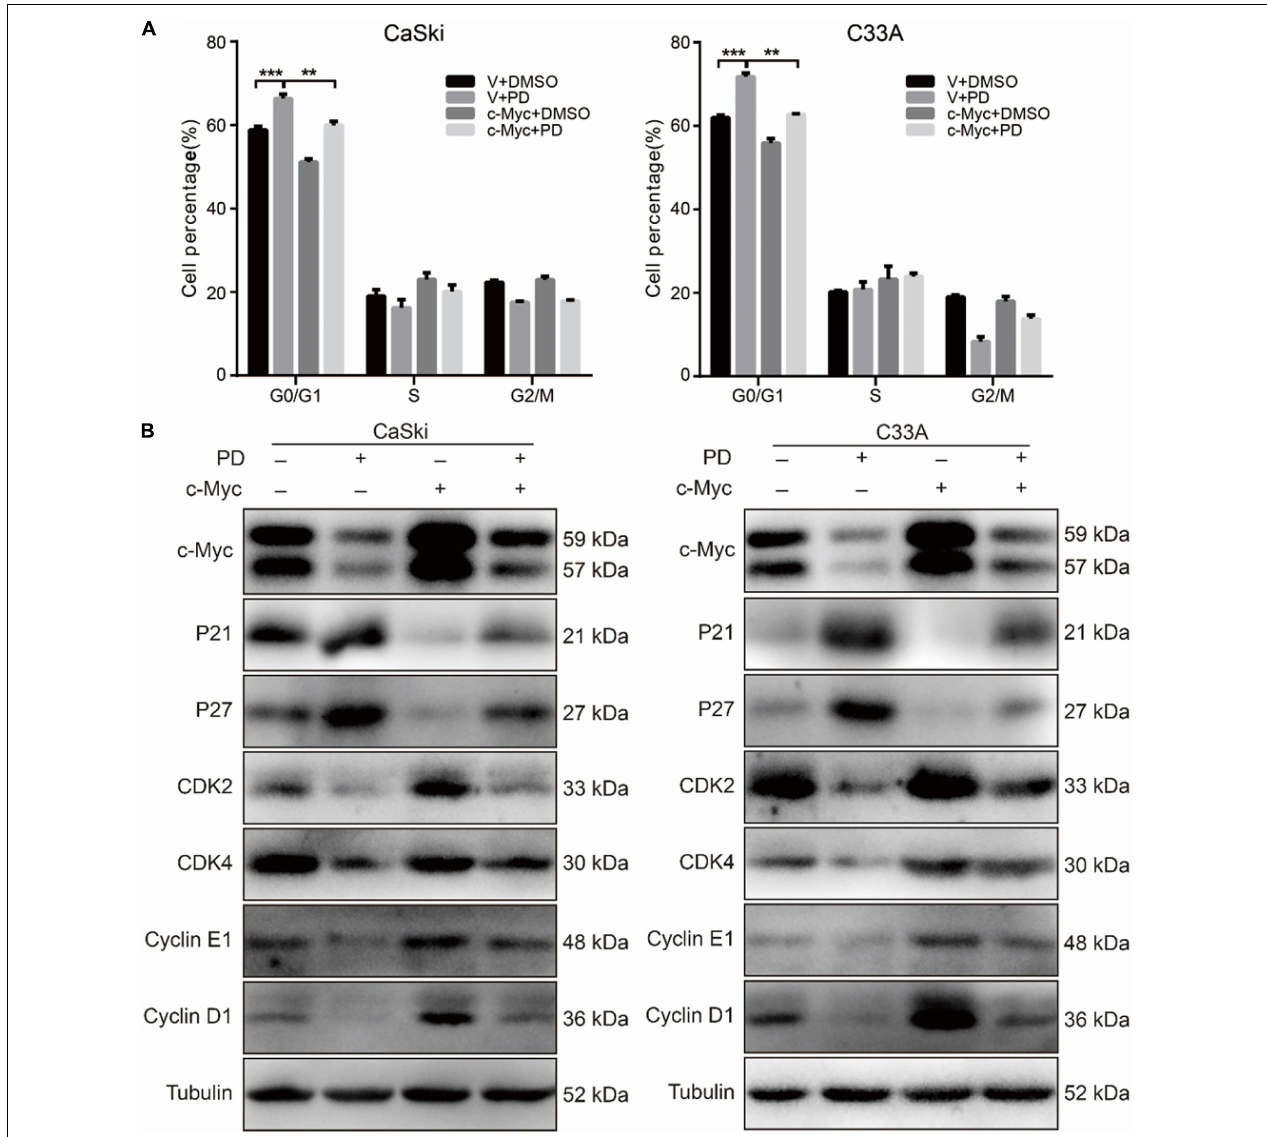
FIGURE 5 | The upregulation of c-Myc rescues polydatin-induced cell cycle arrest. (A) The cell cycle of CaSki and C33A cells was analyzed by flow cytometry in c-Myc-overexpressed cells as well as vector cells after being treated with dimethyl sulfoxide (DMSO) or 200 µ M of polydatin for 48 h. (B) Western blot analysis of cell cycle-related proteins in c-Myc-overexpressed CaSki and C33A cells as well as vector cells after being treated with DMSO or 200 µ M of polydatin for 48 h. Tubulin was used as a control. All data were analyzed using two-tailed Student’s tests. Error bars, ∗ P < 0.05, ∗∗ P < 0.01, and ∗∗∗ P <